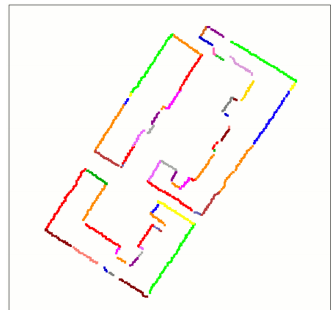
Figure 2c. Set of refined straight lines resulting from the modified RANSAC algorithm